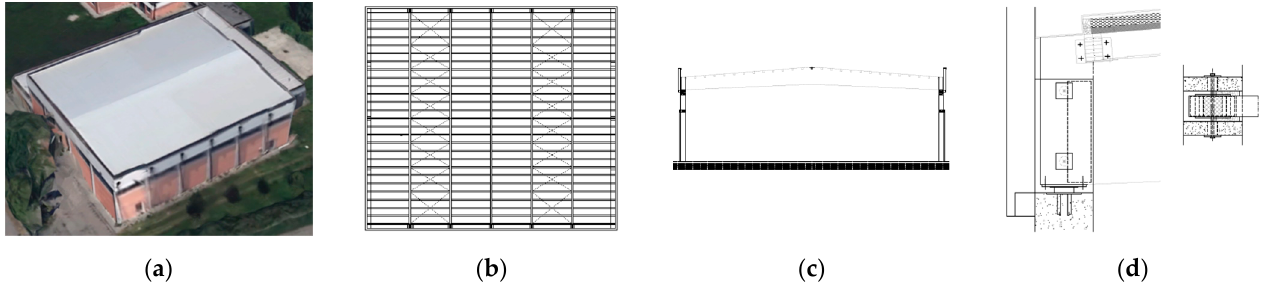
Figure 3. School gym in Carpi (MO, 1995): ( a ) external view, ( b ) plan view, ( c ) section along main beams and ( d ) detail of the connection between column and main beam (courtesy of Rubner Holzbau).